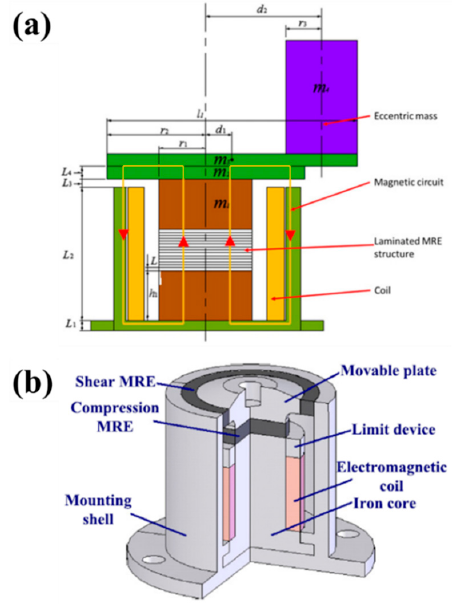
Figure 11. MR elastomer-based vibration absorber involving eccentric mass ( a ) (reprinted with permission from [134], Copyright 2016 IOP Publishing Ltd., Bristol, UK) and shear-compression mixed-mode MRE isolator ( b ) (reprinted with permission from [135], Copyright 2015 SAGE Publications, Thousand Oaks, CA, USA).